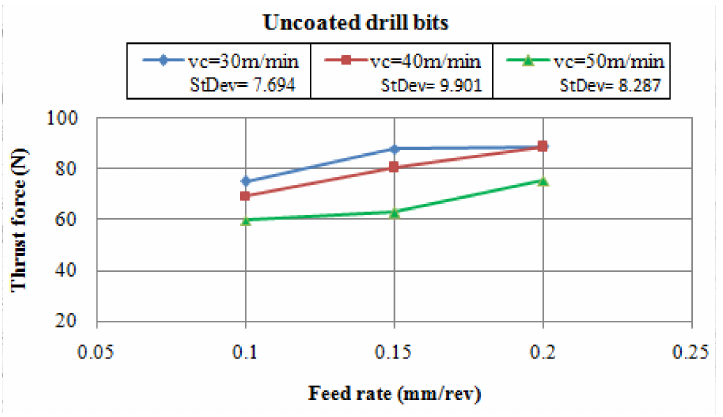
Figure 5. Thrust force variation with feed rates at different cutting speeds when using uncoated drill